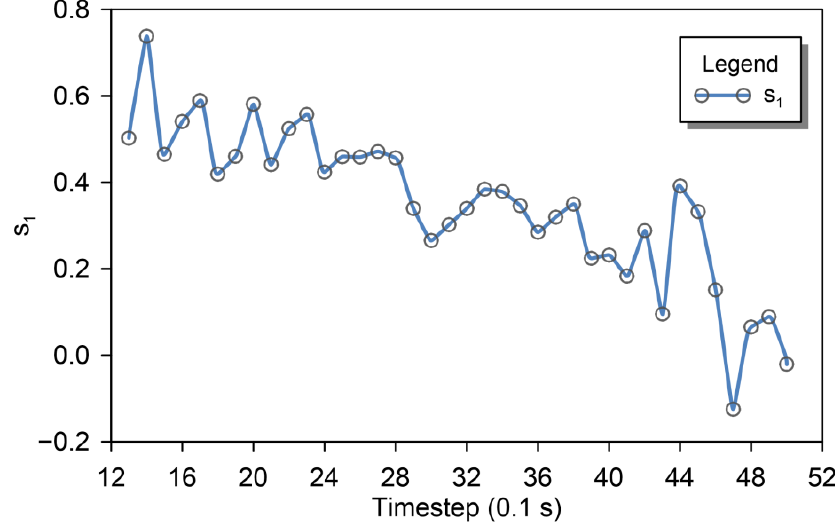
Figure 12. The relationship between 𝑠 1 and